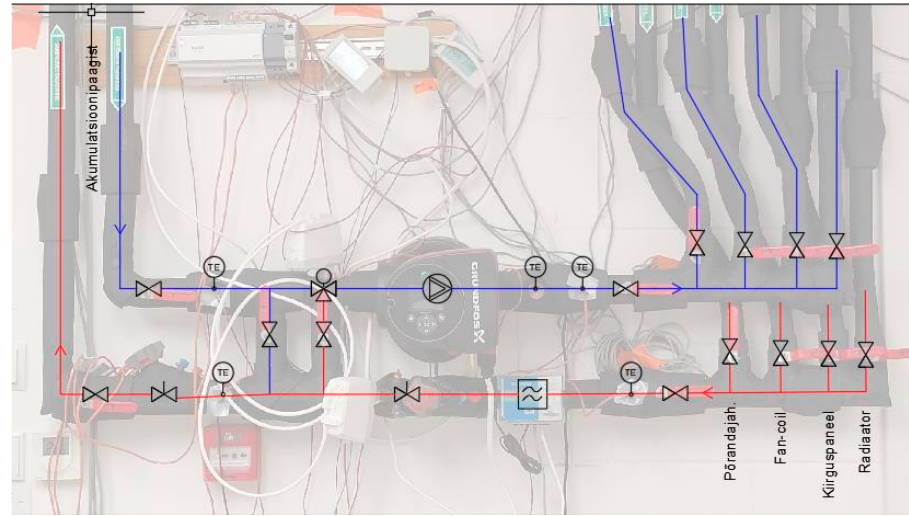
Figure 2. Mixing unit connections: underfloor, fan-coil, cooling panels, radiator (left to right).